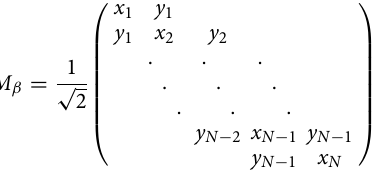
( 0, 1 , chaotic behavior (cid:31) k ∈ ] 2 only occurs when β is extremely small, where the k − ∼